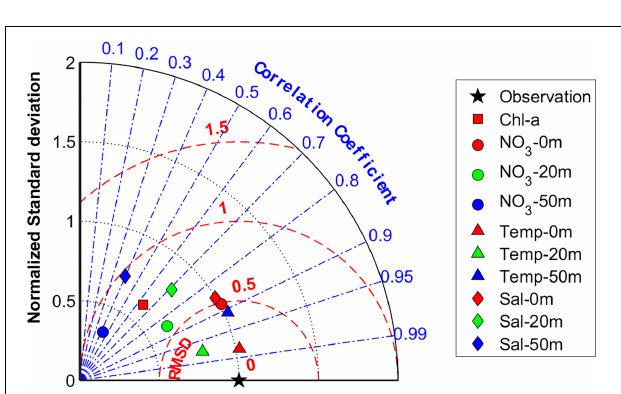
FIGURE 9 | Normalized Taylor diagram comparing simulated monthly mean chlorophyll- a concentration (squares), spatially averaged in the central YS (121.5–125.5 ◦ E, 34.5–39.5 ◦ N), NO 3 − concentration (circles), temperature (triangles), salinity (diamonds) at the surface (red) and depths of 20 m (green) and 50 m (blue) averaged at stations denoted in Figure 2B with satellite, NIFS observation data (the reference field denoted by black star on the x -axis). The radial coordinate is the magnitude of normalized standard deviation from observation. The concentric red semi-circles indicate Root Mean Square Difference (RMSD). The angular coordinate shows the correlation coefficient (denoted by blue dotted lines). YS, Yellow Sea; NIFS, National Institute of Fisheries